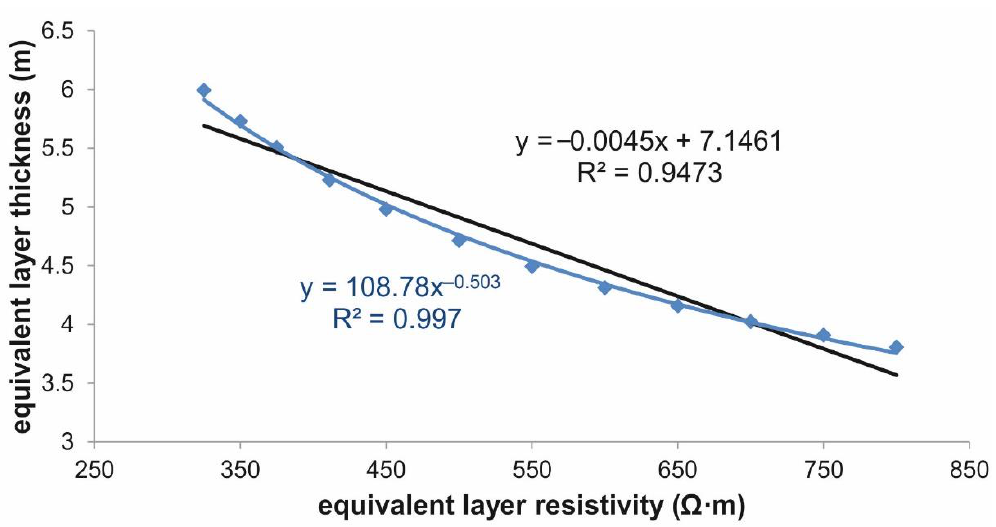
Figure 14. Scatter chart with the resistivity and equivalent layer thickness of layer 2 1D 8. The black lines and equations correspond to a linear fitting and its R 2 and blue represents a potential fitting.